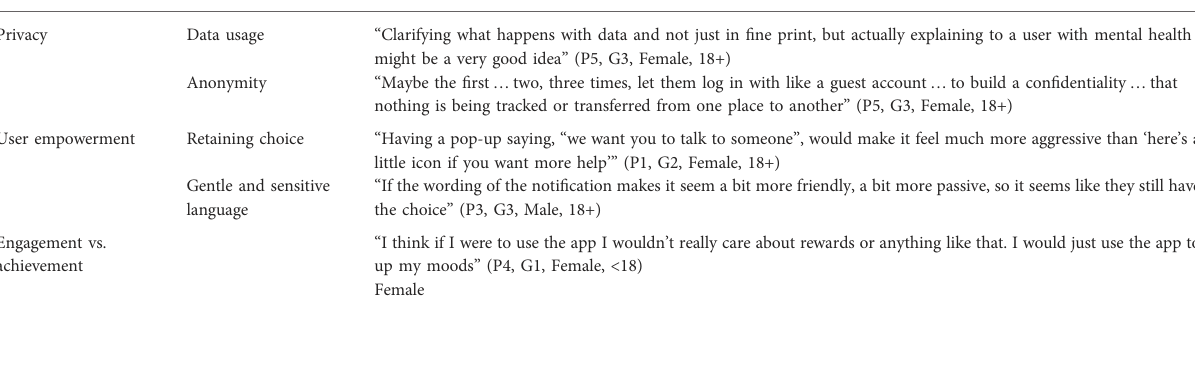
TABLE 2 Themes, sub-themes and supporting